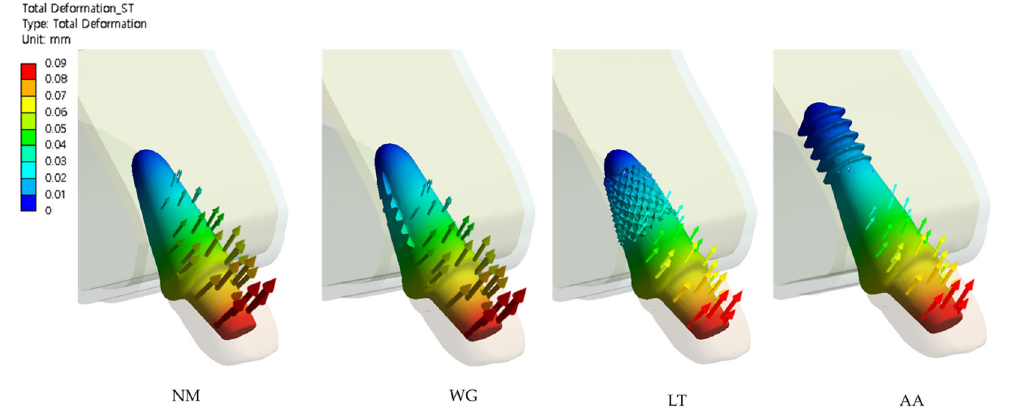
Figure 11. Micro-displacement patterns of root analogue implants (RAIs) in each experimental groups respect to the lowest frictional coefficient (COF) values (COF = 0.1) with directional vectors.